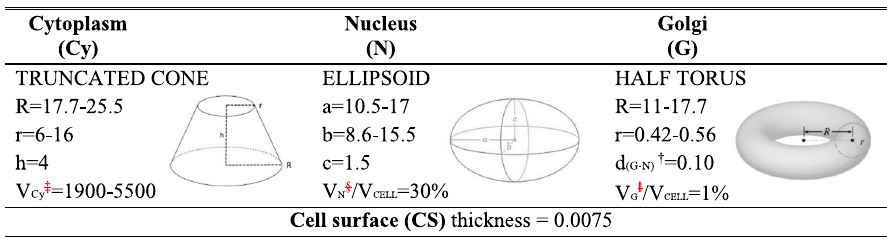
Table 1 Shapes and range of dimensions characterizing the CSG-shaped cell